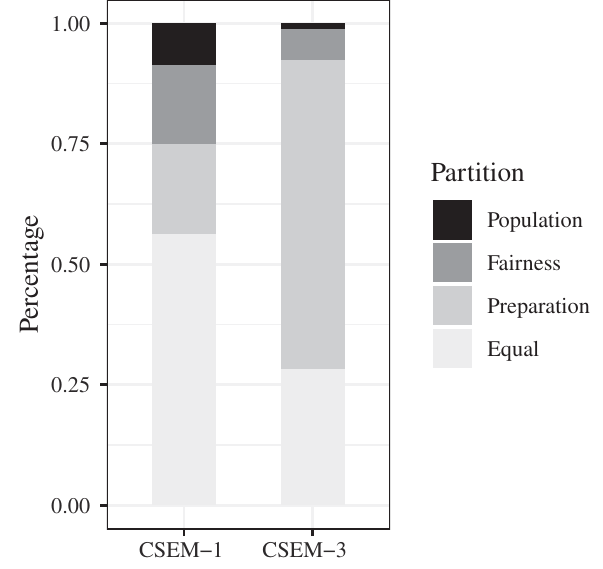
FIG. 4. Relative percentage of each partition using the me- chanics post-test from the previous class as an additional measure of